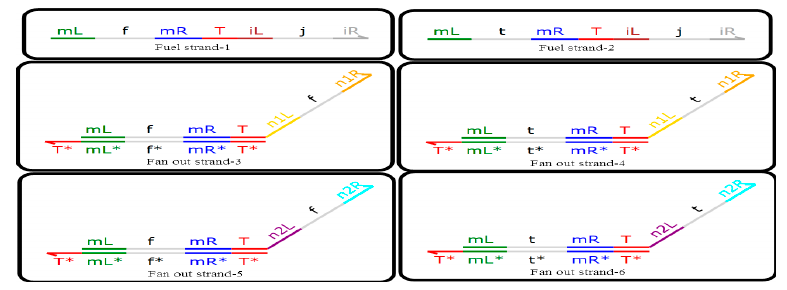
Figure 7. 2-Fan out gate with a domain label.